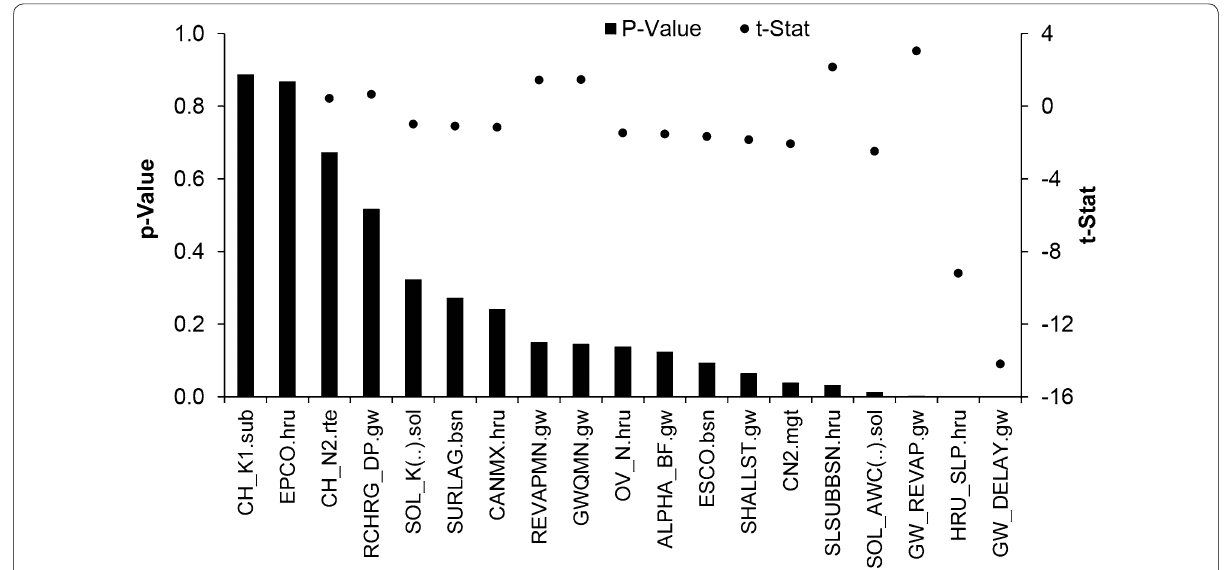
* User defined value based on knowledge from the field. ** Adopted from Table 20-1 of runoff curve numbers for cultivated agricultural lands (Arnold et al. 2013). *** Values from the calibrated SWAT model. Other values without the asterisk (*) were default values from the SWAT database